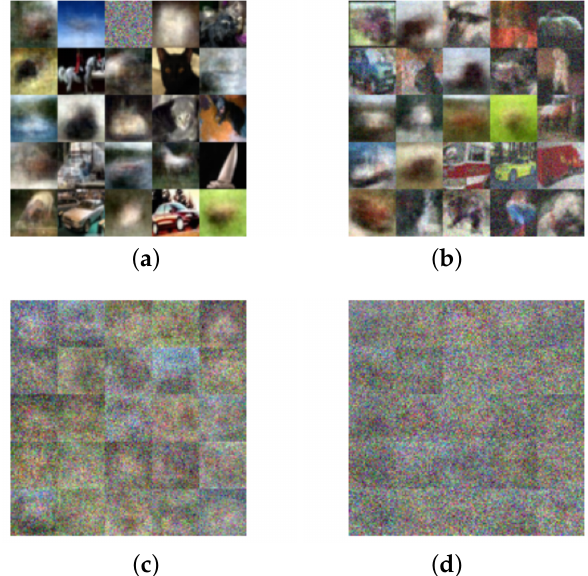
Figure 8. Shown are 25 randomly selected feature detectors out of 2000 learned by the biologically plausible model for CIFAR-10 classification with different levels of added noise. ( a ) Original, no noise. ( b ) Gaussian noise, zero mean, 0.1 STD. ( c ) Gaussian noise, zero mean, 0.5 STD. ( d ) Gaussian noise, zero mean, 1.0